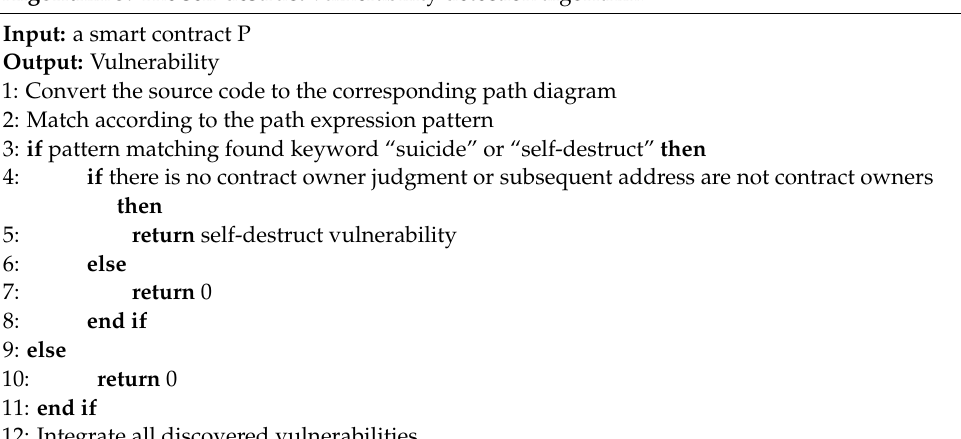
Algorithm 3: The self-destruct vulnerability detection